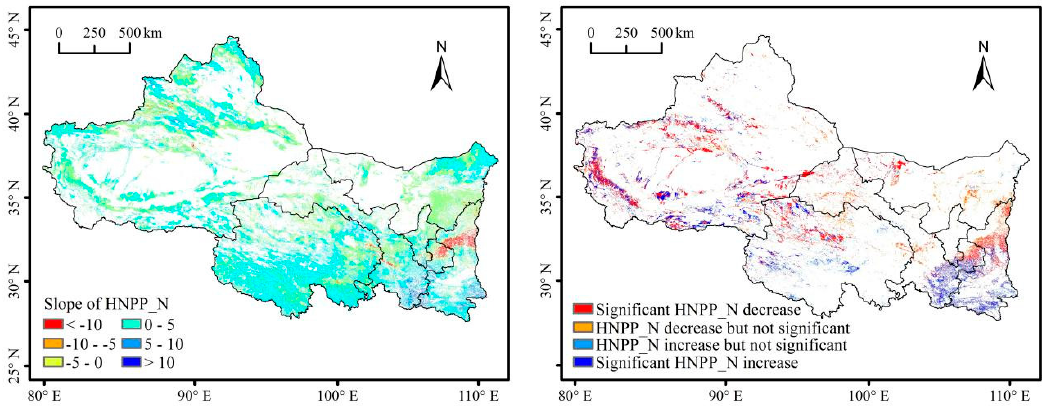
Figure 13. Interannual changing rate and significance of HNPP_N.